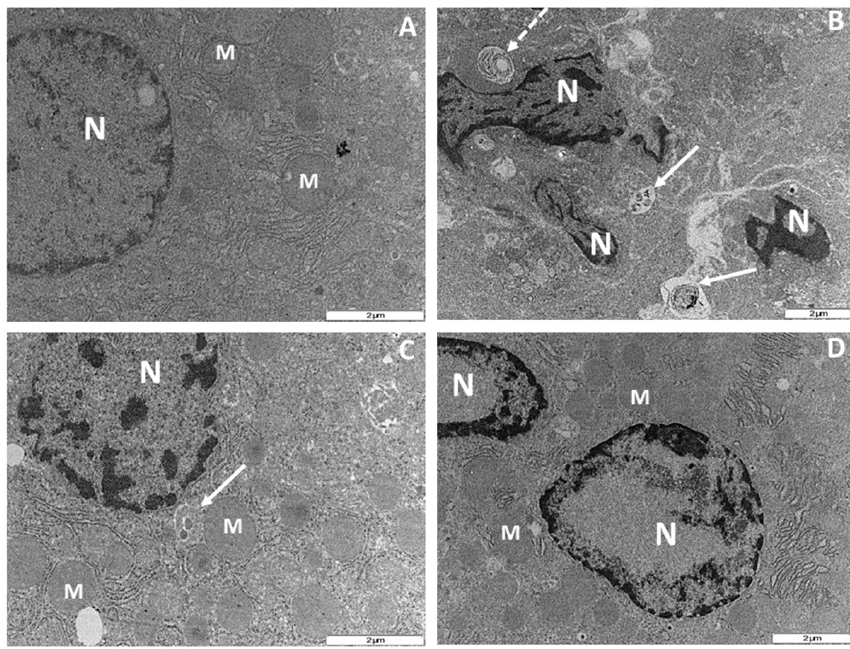
Figure 8. Transmission electron micrograph of rat hepatocytes after 56 days of drug treatment. M = mitochondrion, N = nucleus and ER = endoplasmic reticulum. ( A ) Control rats showing normal nucleus with an even distribution of the nuclear chromatin granules, evenly distributed cytoplasm and preserved mitochondrial architecture; ( B ) d4T ‐ treated rats with severely clumped chromatin granules, broken nuclear membrane and fragmentation of the nucleus. There is an associated condensation of the cytoplasm with appearance of apoptotic bodies (white solid arrows), phagolysosomes (white broken arrows) and sparse mitochondrial population; ( C ) and ( D ) d4T + NAR and d4T + VITE ‐ treated rats, respectively with condensed and fragmented nuclear chromatin granules, numerous mitochondria and even distribution of the cytoplasm. (Original magnification of reference scale markings: 2 μ m = × 15,000). Table 3. Relative quantification of electron microscopy examination of rat hepatocytes. Treatment Group Nuclear Clumping